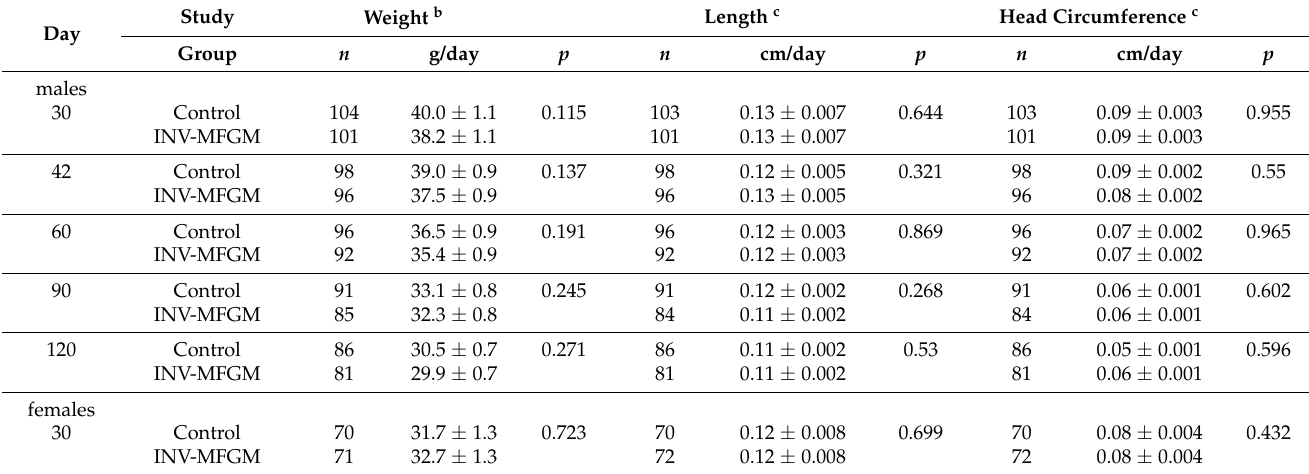
Table 3. Weight, length, and head circumference growth rates from 14 days to 30, 42, 60, 90, and 120 days of age a